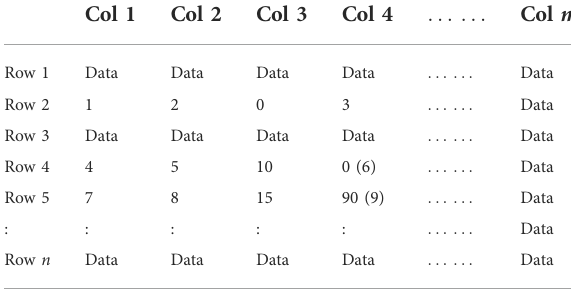
TABLE 1 An example of the random number